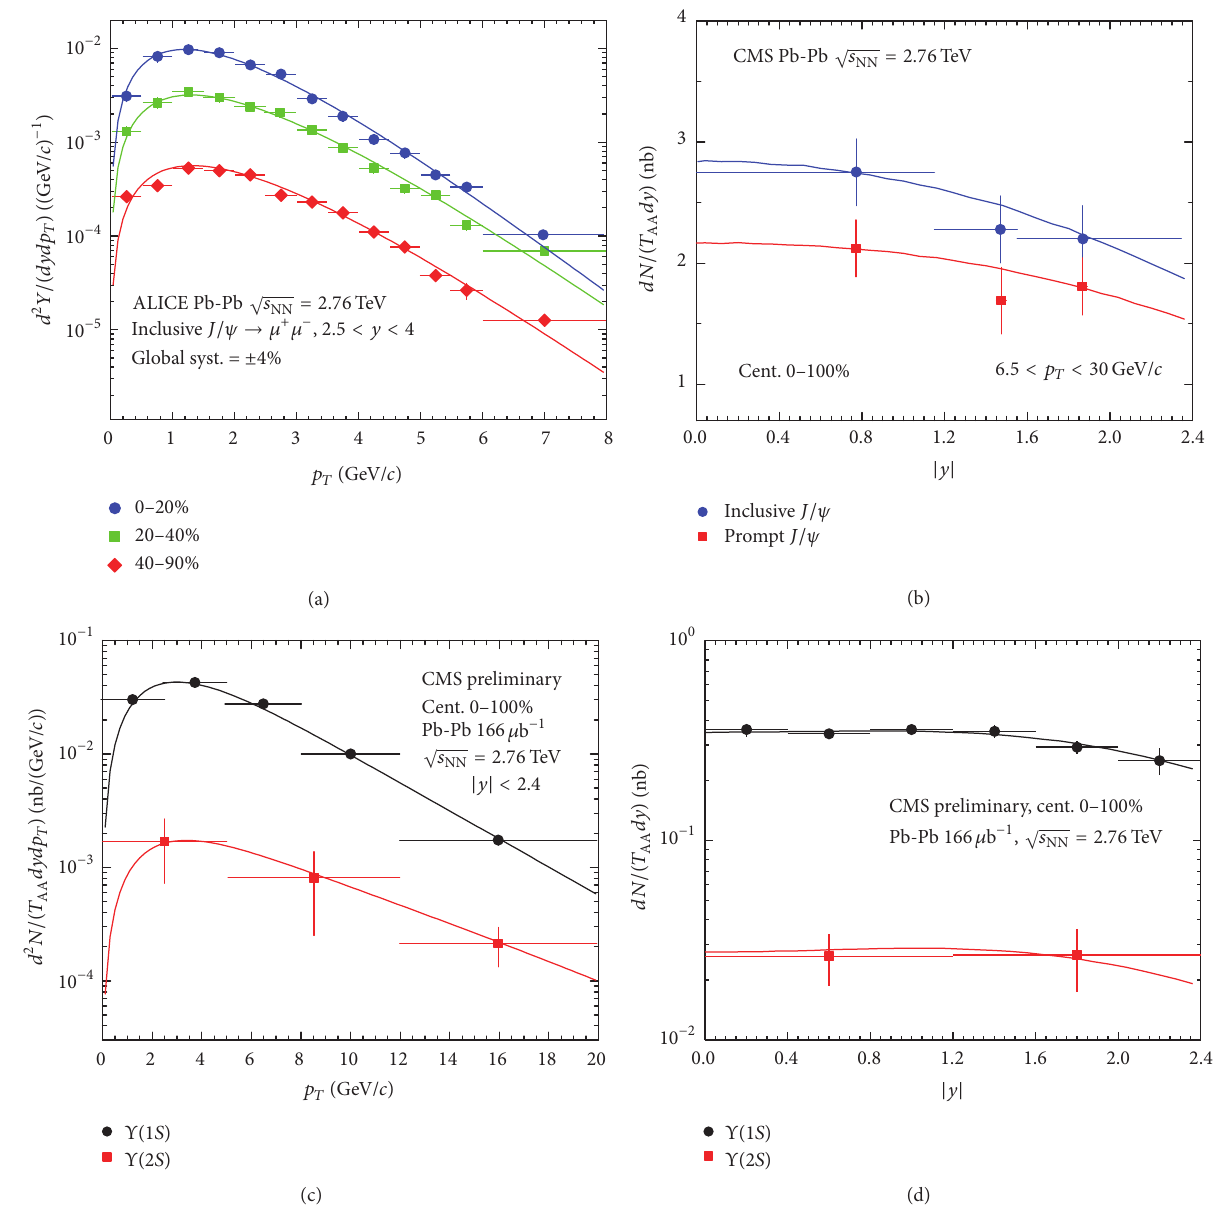
Figure 11: (a) Transverse momentum spectra and (b) rapidity spectra of 𝐽/𝜓 mesons, as well as (c) transverse momentum spectra and (d) rapidity spectra of Υ(1𝑆) and Υ(2𝑆) mesons, produced in Pb-Pb collisions at √𝑠 NN = 2.76 TeV, where 𝑌 on the vertical axis denotes the yield and 𝑇 AA denotes the nuclear overlap function which depends on the collision centrality. The closed symbols represent the (preliminary) experimental data of the ALICE [38] and CMS Collaborations [39, 40] in different conditions shown in the panels, and the error bars are only the systematic uncertainties. The curves are our results calculated by using the hybrid